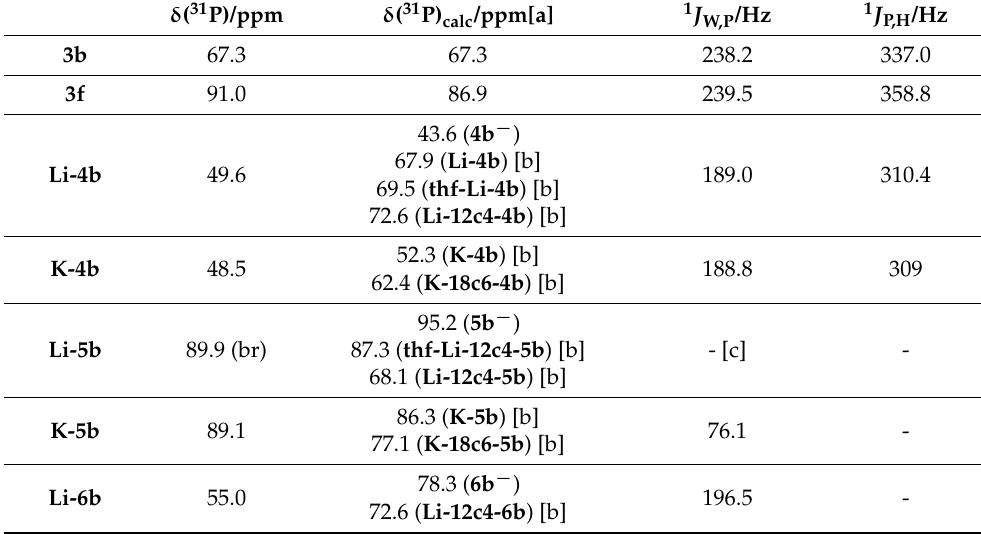
Table 2 contains selected 31 P NMR data of the Li/K-4b and Li/K-5b in THF solu- tion. The comparison of the two metalated derivatives M-4b and M-5b revealed that their experimentally observed resonances were almost invariant, i.e., there was no clear cation dependency. The values are very close to the computed (GIAO/TPSS-D3/def2- most likely parallels the occurrence of solvent and/or crown ether separated ion pairs in solution. Table 2. Selected experimental and calculated NMR data (THF) of species that might result in the deprotonation